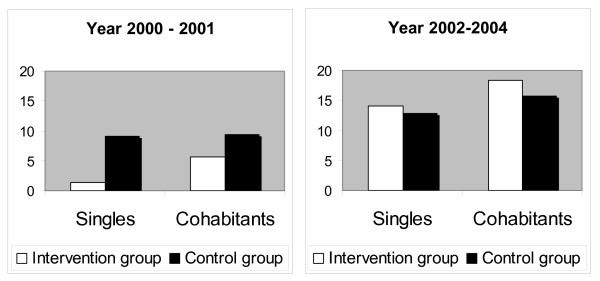
Distribution of mortality during and after the trial. (%).